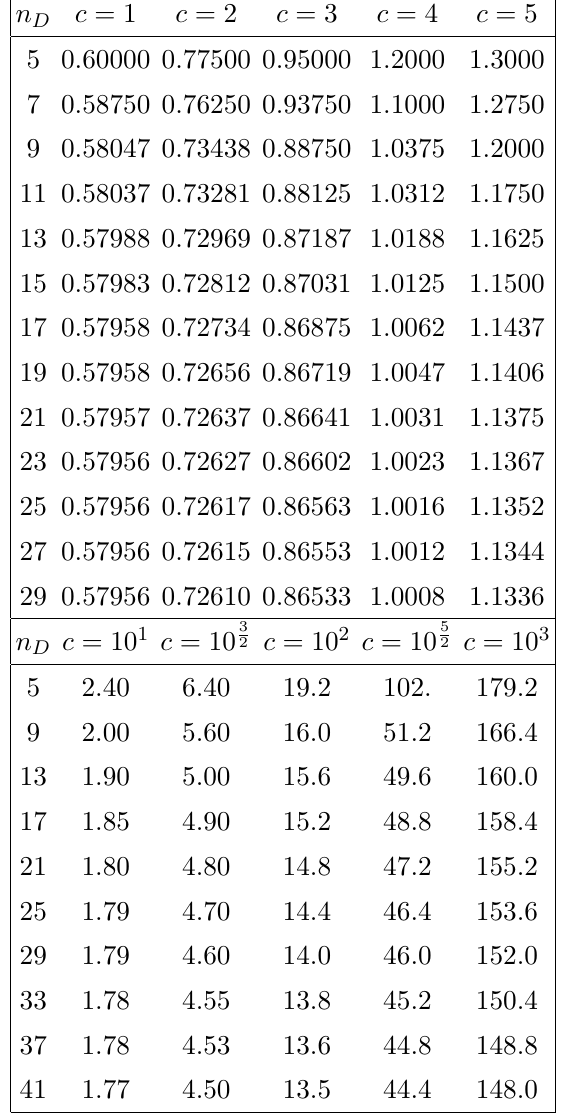
Table 1 . Bounds on the dimension of lightest charged state assuming the theory has U(1) symmetry, as a function of c and the number n D of derivatives used in the bootstrap functionals. extrapolate the bounds to n ! 1 and c ! 1 by (cid:12)tting the (cid:12)nite n and c results to a D D linear function of 1 and 1 =n and extrapolating, as shown in (cid:12)gure 1. In this test we take D c (cid:28) = i(cid:12) with (cid:12) real to avoid the complication of spin. It is not understood a priori why the 2 (cid:25) form of this (cid:12)t works, but empirically it agrees well with the data at large c and n . D Similarly to the results of [10], extrapolating in n and then c provides a parametrically D stronger bound than the (cid:12)nite n D